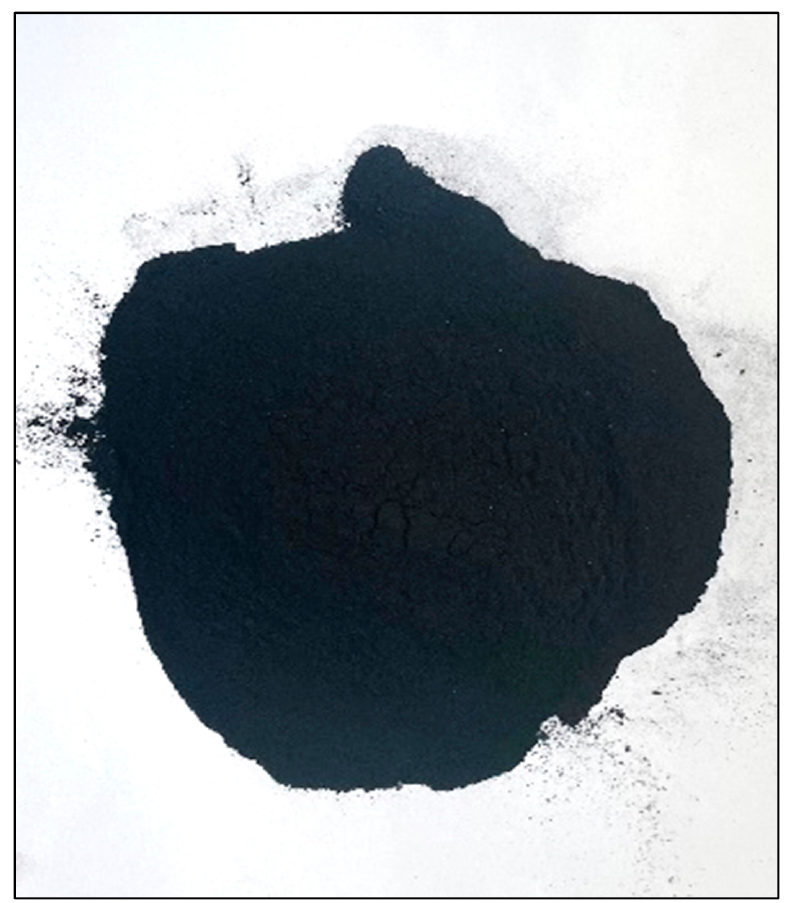
Figure 3. HA reagent. 3. The cement used in the test is ordinary Portland cement.